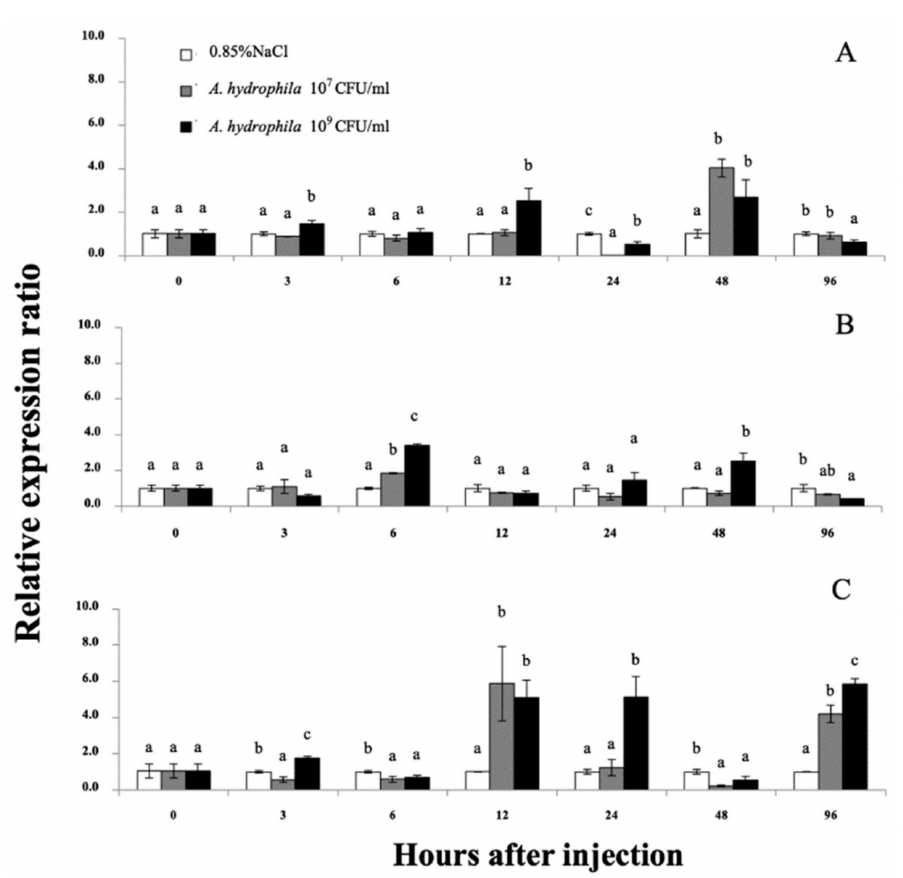
Figure 8. The Mr-hsp40 mRNA expression levels relative to β -actin levels analyzed by qRT-PCR in the gills ( A ), hepatopancreas ( B ), and hemocytes ( C ) of giant river prawns after challenge with Aeromonas hydrophila . The values are shown as means and SDs, n = 6. Data with different letters (a, b and c) were significantly different ( p < 0.05) at the same exposure times. Descriptions of this part are also provided for Figure